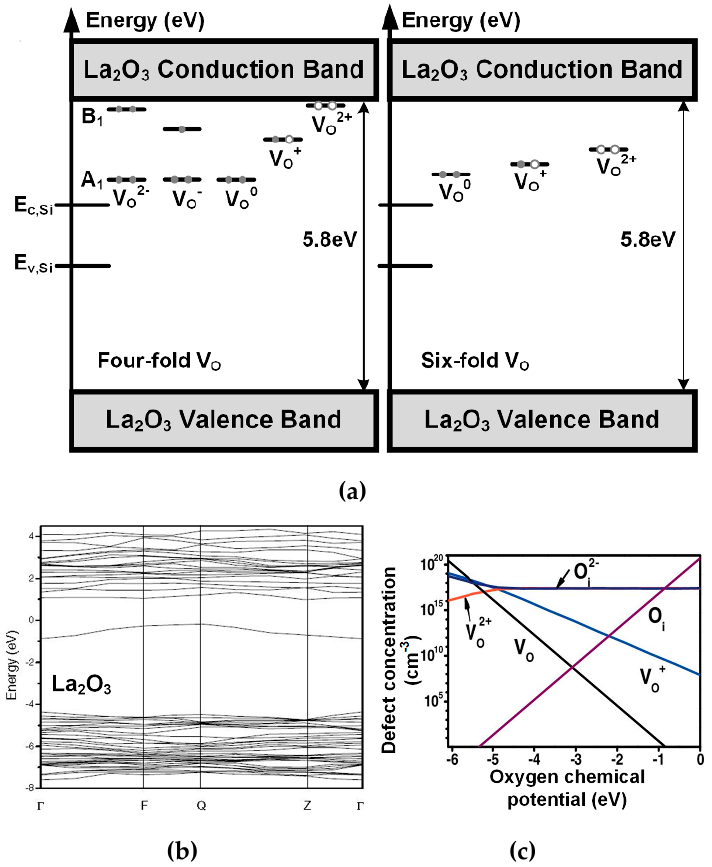
Figure 9. ( a ) Energy levels of four-fold and six-fold oxygen vacancies in La 2 O 3 [49], ( b ) band structure of La 2 O 3 with neutral oxygen vacancies [51], and ( c ) defect concentration in La 2 O 3 at 1300 K [54]. Trap at the La 2 O 3 /semiconductor interface is another concern that impacts the device